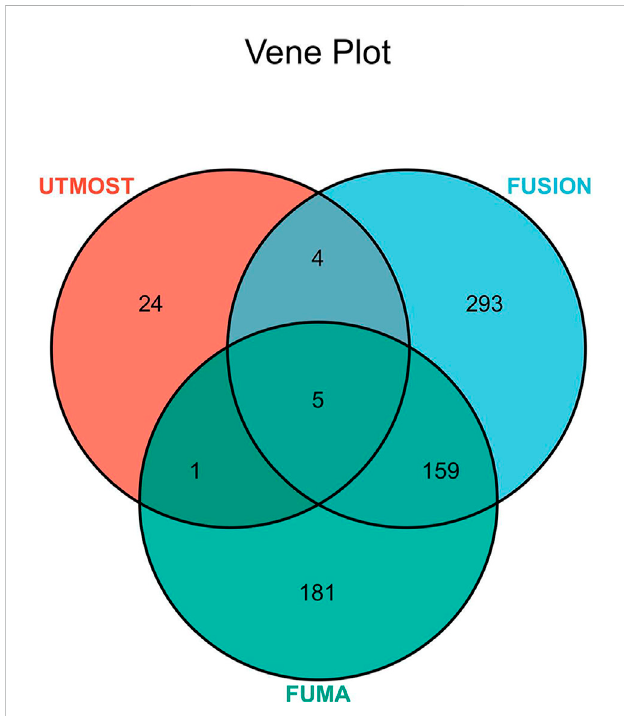
FIGURE 3 Venn diagram. FUMA identi fi ed 346 signi fi cant genes associated with hypertension, FUSION identi fi ed 461, and UTMOST cross-tissue analysis identi fi ed 34, of which 5 were